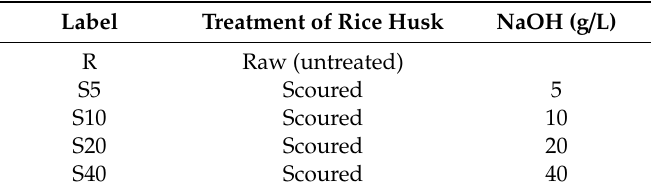
Table 1. Sample label and summary of alkaline scoured rice husk treated with different concentrations of sodium hydroxide at 90 °C for 30 min.